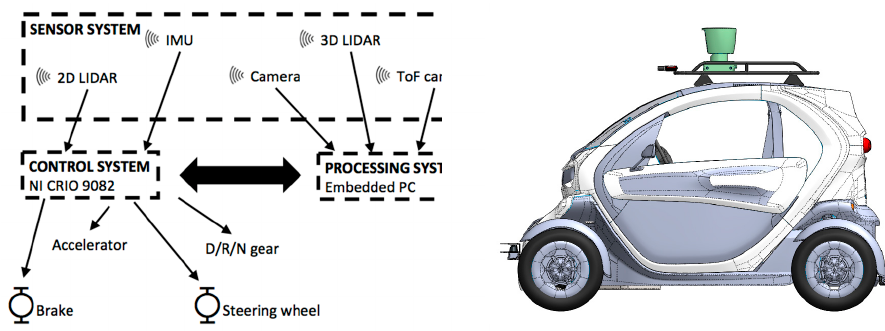
Figure 1. Main components of the CIC architecture.